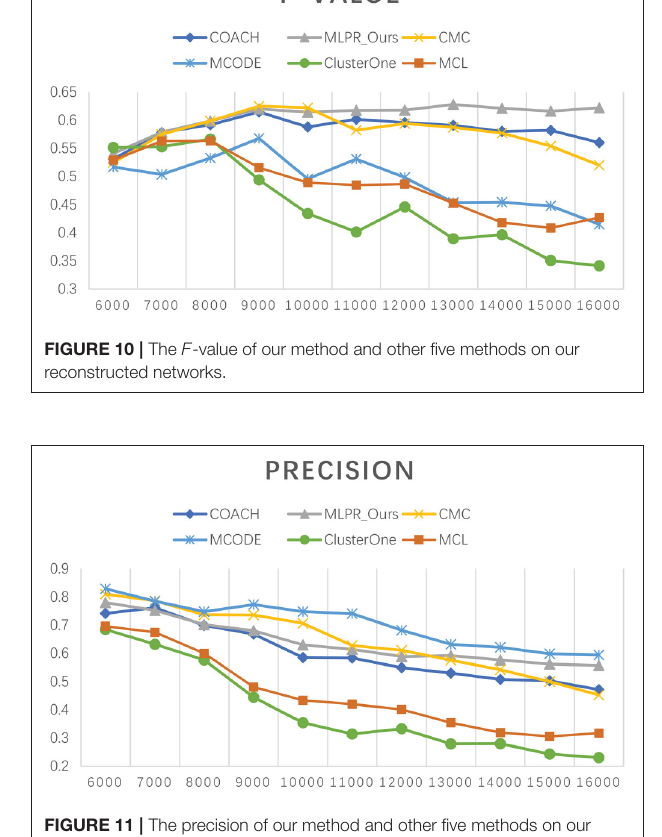
FIGURE 11 | The precision of our method and other five methods on our reconstructed networks.